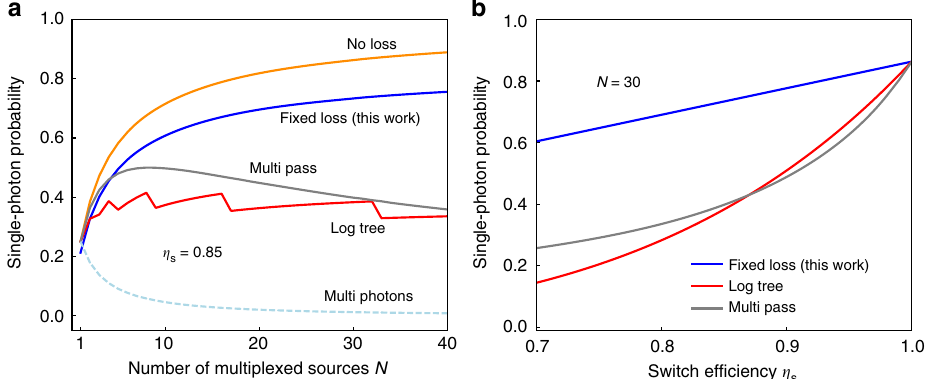
Fig. 2 Theoretical prediction of scaling performance for various switching schemes. a The maximum single-photon heralding probability for a single source ( N = 1) is 0.25. For an ef fi ciency of η s = 0.85 (0.7 dB loss) per switch, the single-photon emission probability for both log-tree and multi-pass schemes reaches a maximum of 0.41, 0.50, respectively, and then saturates for large N due to scaling losses. In contrast, additional multiplexed sources always result in improved performance for the fi xed-loss scheme, with p mux ( n = 1) = 0.75 for N = 40 sources. The multi-photon emission probability p mux ( n > 1), ignoring switching losses, is shown as the dashed light blue curve, and is <1% for N = 40 modes. b Single-photon heralding probability for various switching schemes as a function of switch loss, for a fi xed number of sources N = 30. The fi xed-loss scheme is signi fi cantly more robust to variability in switching losses. Note that the maximum heralding probability for η s = 1 is not equal to 1 since the heralding detectors are non-photon-number resolving